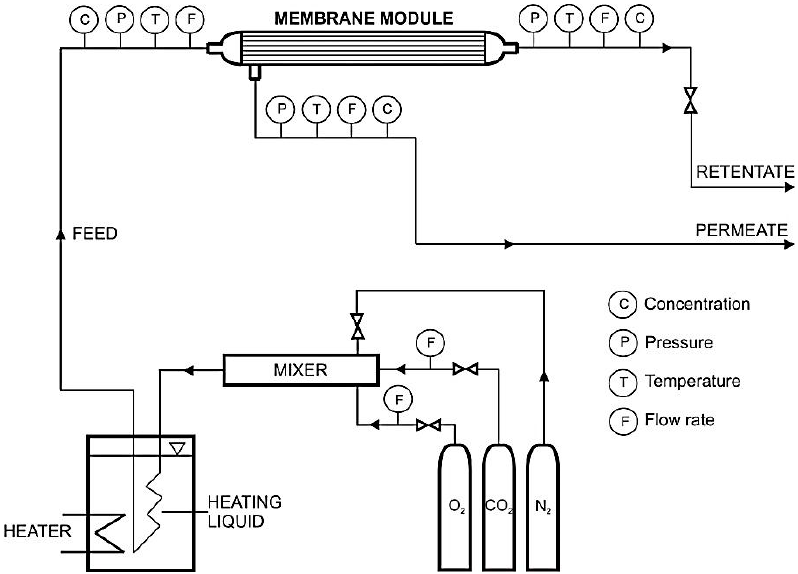
Figure 1. Experimental setup for gas permeation studies.